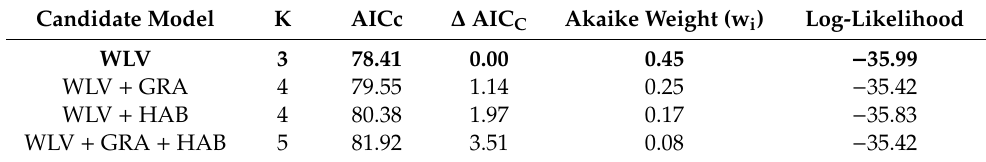
Table 3. Model selection of seven candidate models for predicting the probability of beaver lodge abandonment in the between-habitat models. All models included a random intercept for the beaver lodge